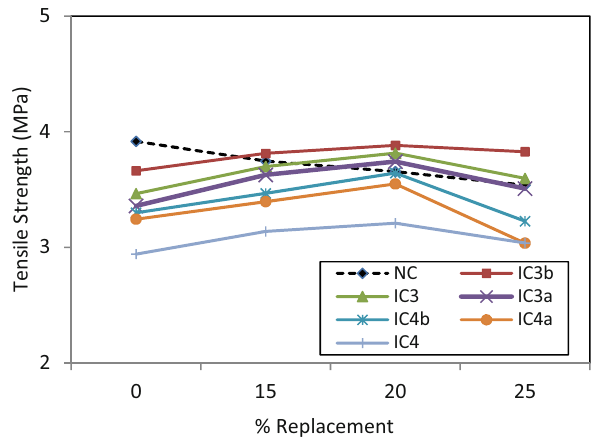
Fig. 13 Effect of percent replacement on splitting tensile strength (Phase